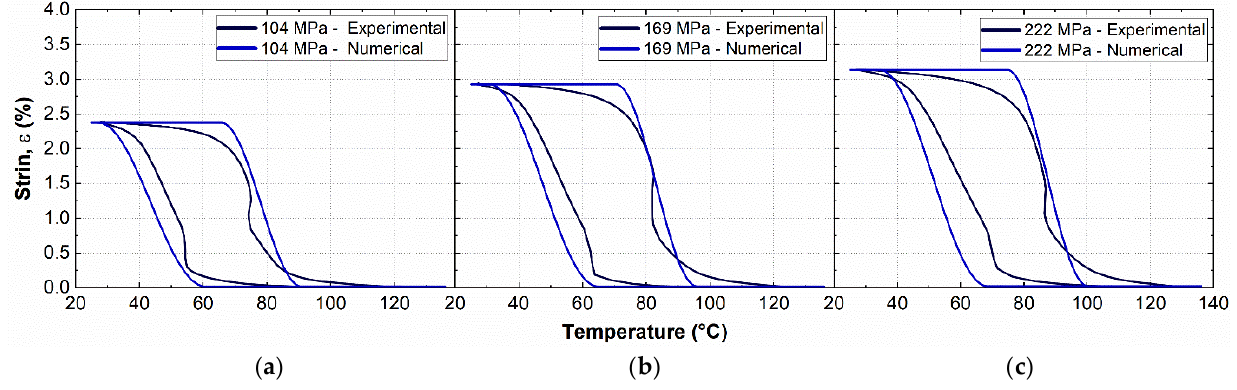
Figure 8. Comparison between experiments and numerical simulations of the strain – temperature hysteresis for a martensite pre-strain ε M = 4% under different constant stress recovery conditions: ( a ) 104 MPa, ( b ) 169 MPa and ( c ) 222 MPa. ( a ) 104 MPa, ( b ) 169 MPa and ( c ) 222